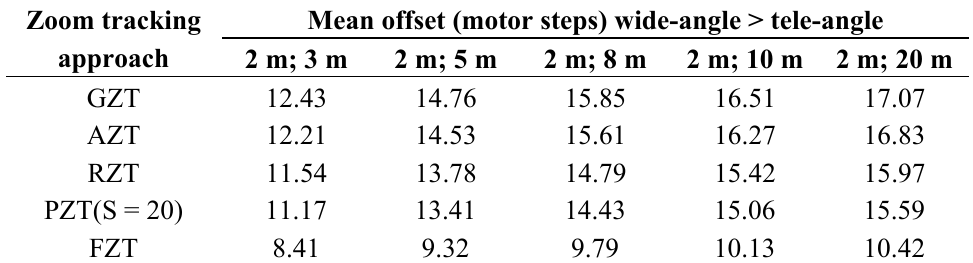
Table 4. Tracking accuracy for switching objects.